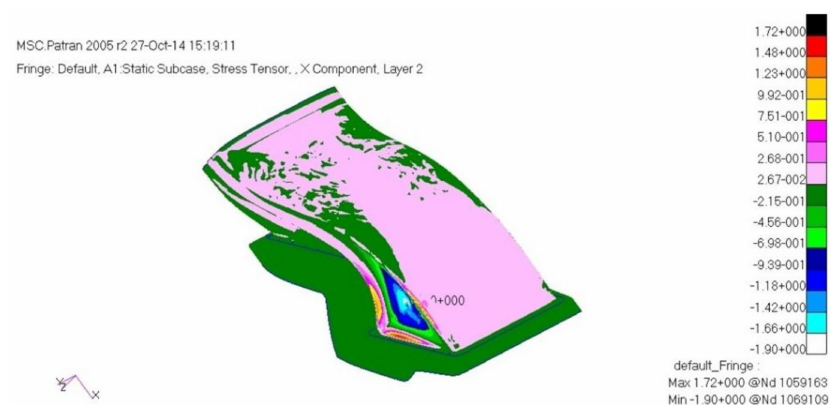
Figure 10. Stress analysis result: layer